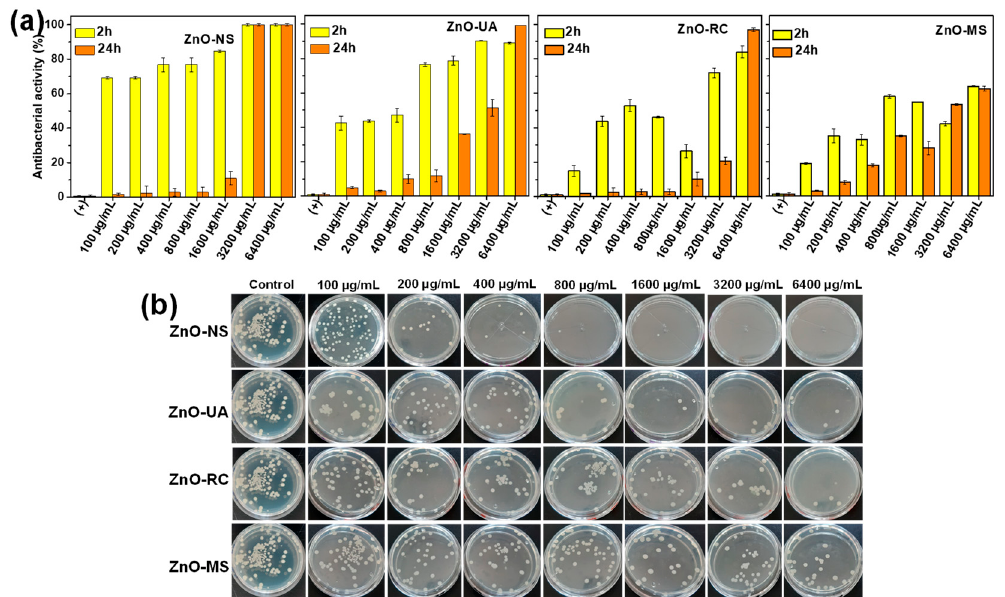
Figure 7. ( a ) Antibacterial activity test of ZnO nanoparticles obtained from Sargassum ssp. at different experimental conditions. ( b ) Representative photographs of plates obtained from the interaction of ZnO nanoparticles after 2 h of contact against Gram-positive S. aureus .